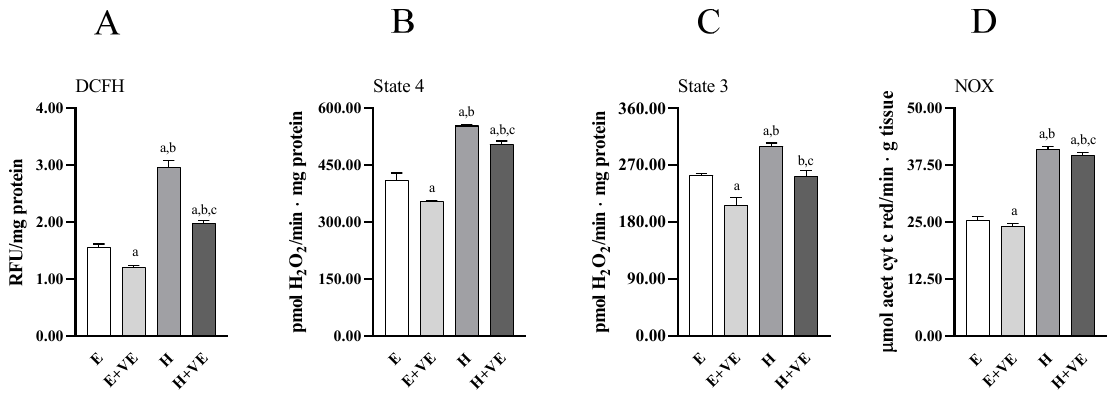
Figure 2. Lipid (hydroperoxides, HP, panels ( A , D )) and protein (protein bound carbonyls, CO, panels ( B , E )) oxidative damage markers; and in vitro response to oxidative stress ( ∆ HP, panels ( C , F )), in liver homogenate (upper panels) and isolated mitochondria (lower panels) from E, E + VE, H and H + VE rats. Values are means ± SEM of eight determinations from different rats. Each determination is the mean of three independent measures. E, euthyroid; E + VE, euthyroid fed vitamin E supplemented diet; H, hyperthyroid; H + VE, hyperthyroid fed vitamin E supplemented diet. a significant vs. E. b significant vs. E + VE. c significant vs. H. The level of significance was chosen as p < 0.05.